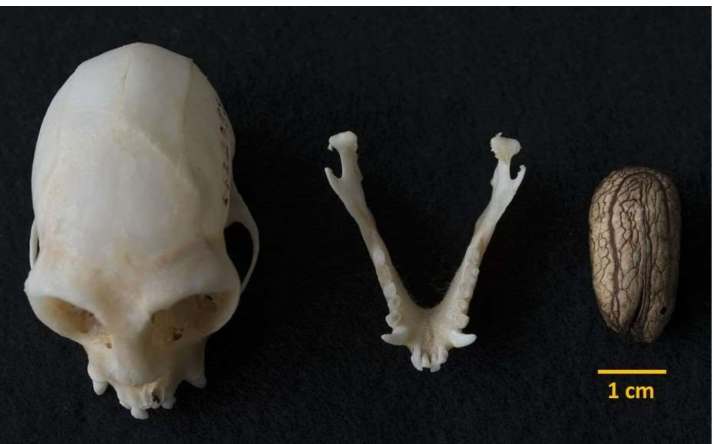
Figure 3. Skull and mandible of a Leontocebus illigeri (which is identical in size to Leontocebus nigrifrons